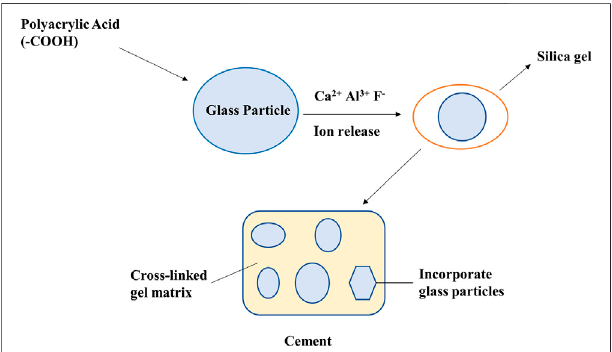
FIGURE 1 | Manufacturing method of glass ionomer cement